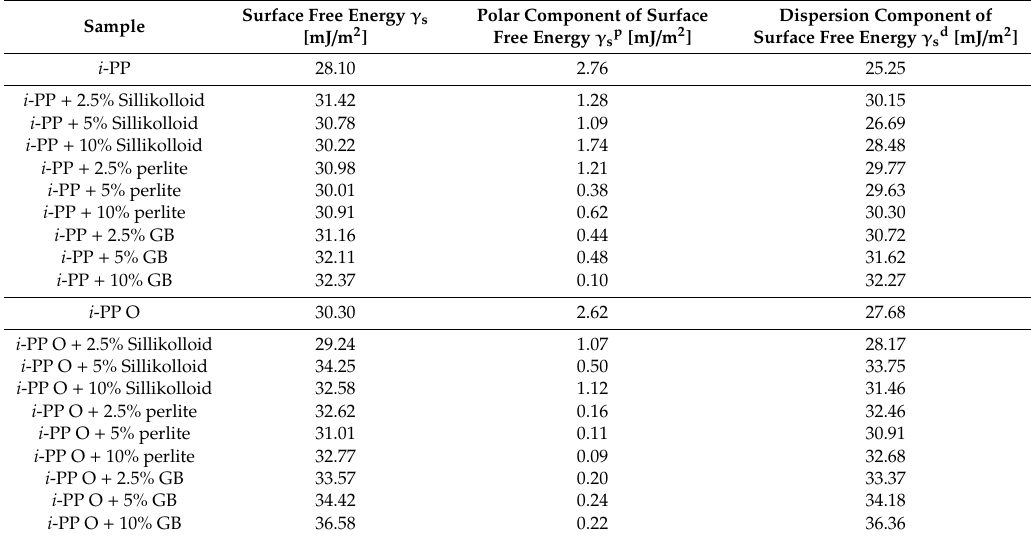
Table 2. Surface free energy and its components for unoriented and oriented (O) isotactic-polypropylene ( i -PP) films with di ff erent content of Sillikolloid, perlite, and glass beads (GB).